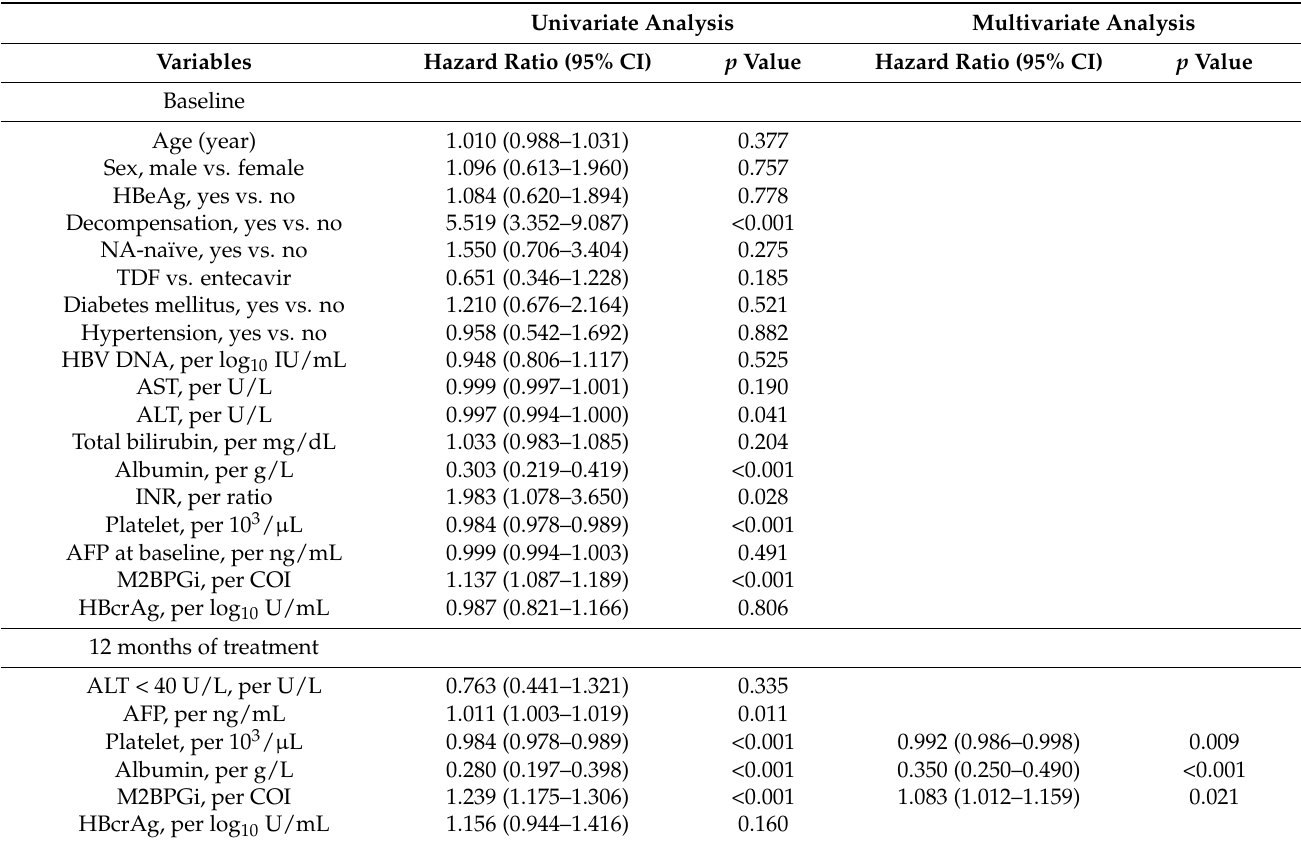
Table 6. Univariate and multivariate analyses of factors associated with liver related mortality or liver transplantation. Univariate Analysis Multivariate